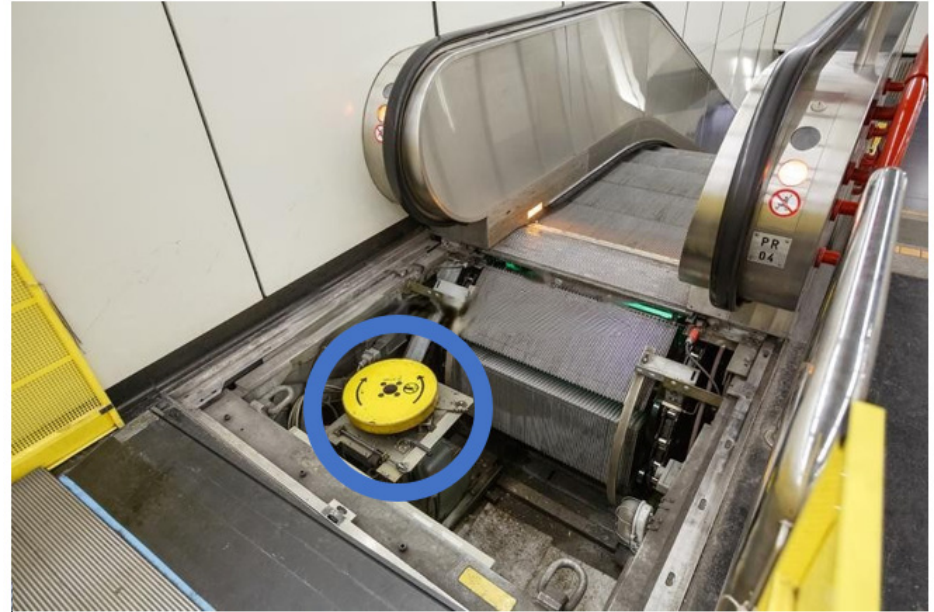
Figure 9. An electric motor in a subway escalator.